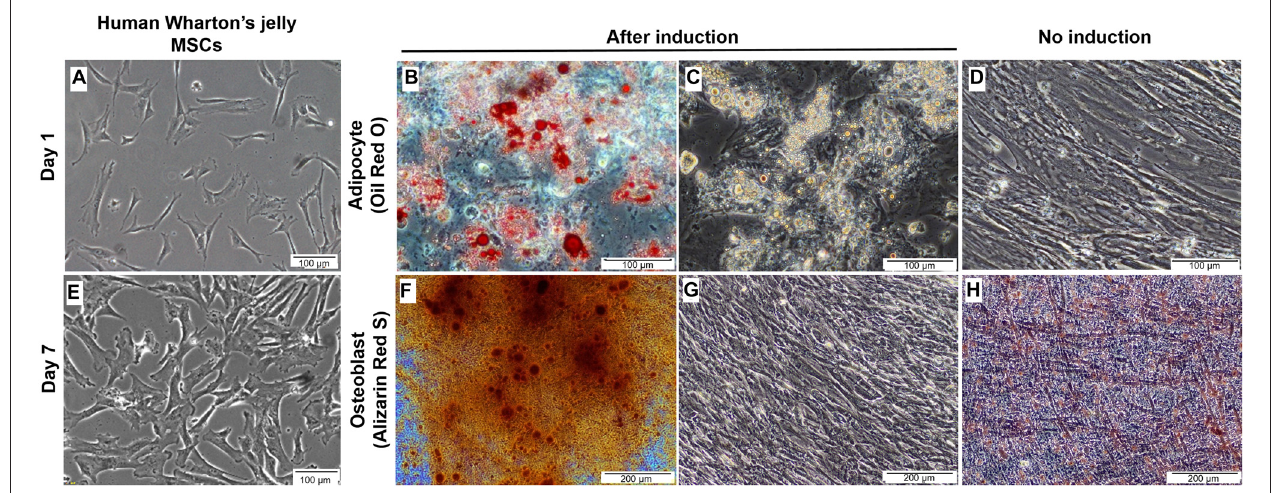
FIGURE 2 | Culture, expansion and characterization of mesenchymal stem cells from human Wharton’s jelly. (A) Morphology of single cell-derived, clonally expanded MSCs. (B) Cultured MSCs were then culture-expanded and maintained between 80% and 90% confluence. (C,D) Differentiation of human Wharton’s jelly MSCs into adipocytes. The lipids were stained red with Oil Red O when compared to non-induced cells and cell nuclei were stained blue with hematoxylin (C) . Small lipid droplets were observed in the cytoplasm of the cells during early incubation and they became large due to lipid accumulation (D) . (E) The non-induced MSCs cultured in the growth media were stained negative by Oil Red O. (F,G) Morphological examination of MSCs induced towards osteogenic lineage. Small, crystal-like elements were observed accumulated across the monolayer cell surface at the end of the differentiation stage. The overcrowded crystals created difficulty in distinguishing the morphological changes in the cells (G) . The amorphous calcium deposit was stained orange red at pH 4.0 with Alizarin Red S, when compared to non-induced culture (F) . (H) The non-induced MSCs cultured in the growth media were stained negative by Alizarin Red S. Cells were imaged with a phase contrast